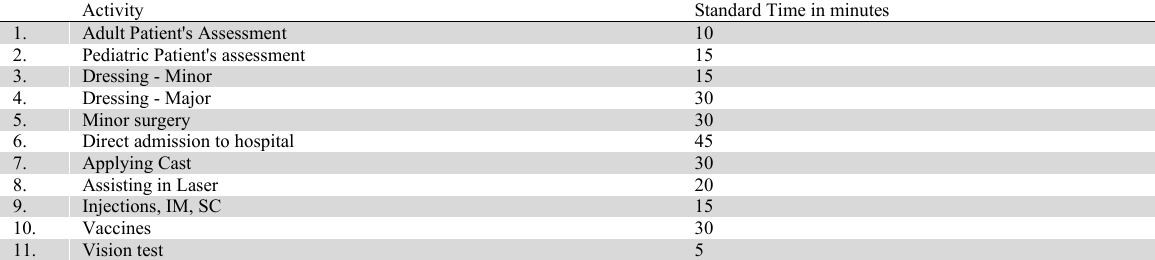
Example list of the nursing activities, which are performed in the outpatient's department with the estimated average